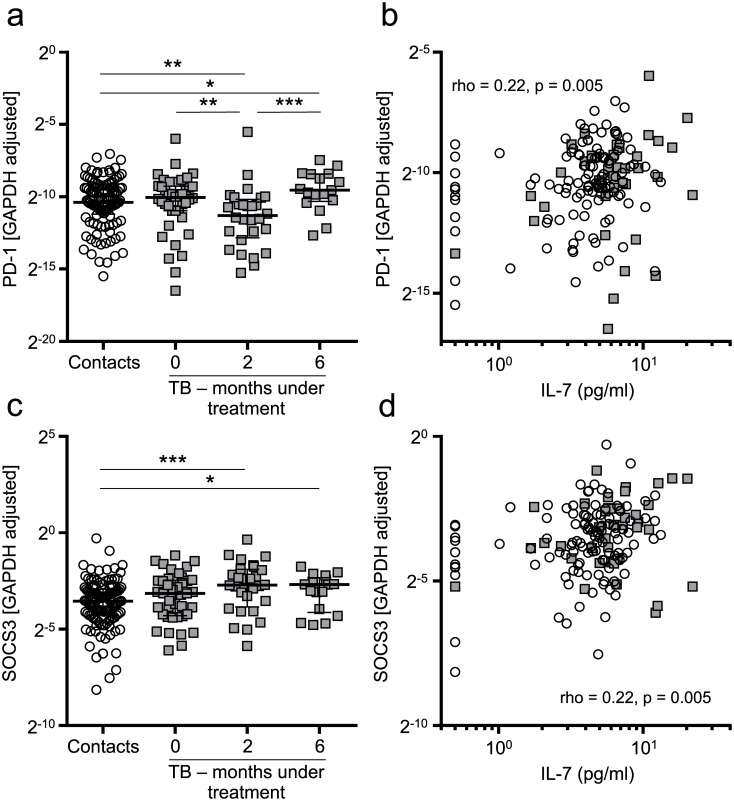
PD-1 and SOCS3 mRNA expression of CD4+ T cells from tuberculosis patients and healthy contacts.The expression of PD-1 (a) and SOCS3 (c) was determined for mRNA isolated from CD4+ T cells, using Glyceraldehyde 3-phosphate dehydrogenase (GAPDH) as a reference. Cycle threshold differences (2-ΔCt) are shown for healthy contacts [n = 117 (PD-1), n = 119 (SOCS3)], and for tuberculosis patients prior to (0 months, n = 40), during (2 months, n = 28), and after (6 months, n = 17) treatment. Median and interquartile range is depicted. Spearman correlation between plasma IL-7 and (b) PD-1 or (d) SOCS3 for healthy contacts (circles) or tuberculosis patients (squares) prior to treatment. Each symbol indicates mean values of duplicates from each individual donor. Due to a low overlap between tuberculosis patients, exact Mann-Whitney U test used for comparison of all groups. Nominal p-values are indicated as * p < 0.05, ** p < 0.01, *** p < 0.001.